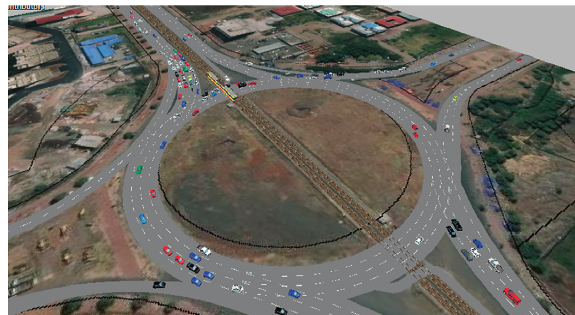
Figure 3: Snapshot of the CMC level crossing during simulation